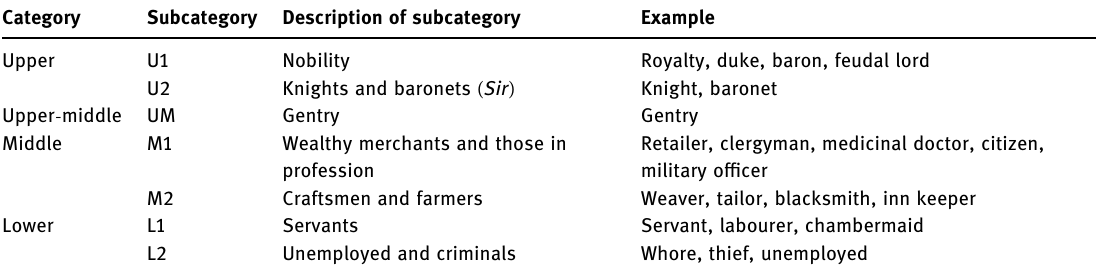
Table 1: Categories of social status